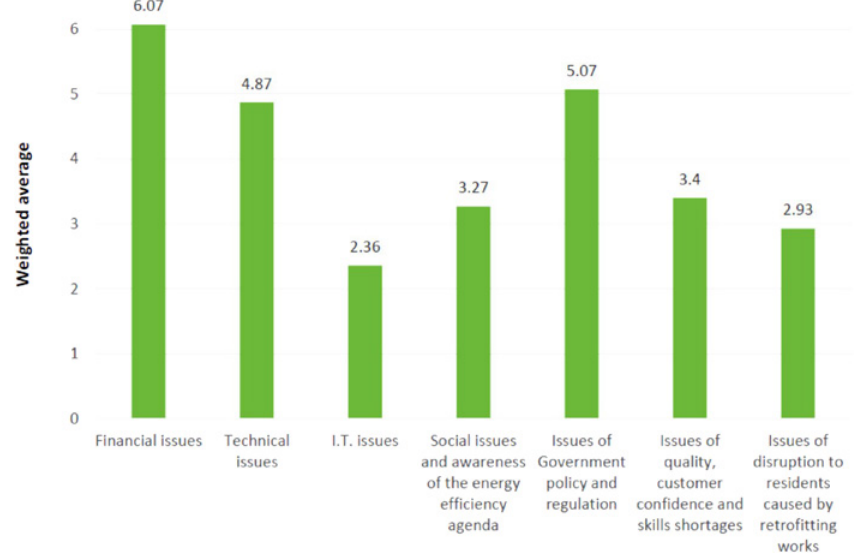
Figure 2 Weighted average rankings for survey data the categories of barriers and